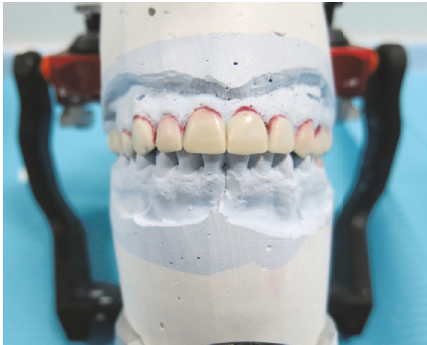
Figure 5: Diagnostic wax-up over the semiadjustable articulator.